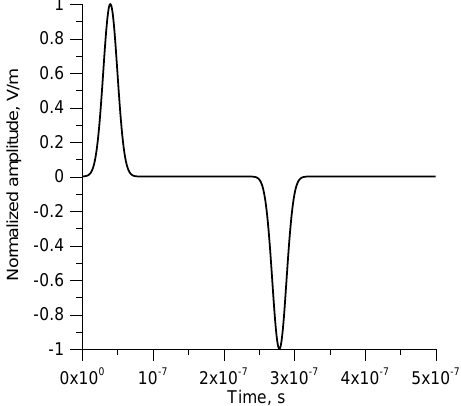
Figure 3. Normalized radiation field generated along the direction θ = 20 ◦ at a distant point by a long dipole. The dipole is excited by a Gaussian current pulse. In the calculation, σ = 10 ns and τ / ( L / c ) = 0.01 .